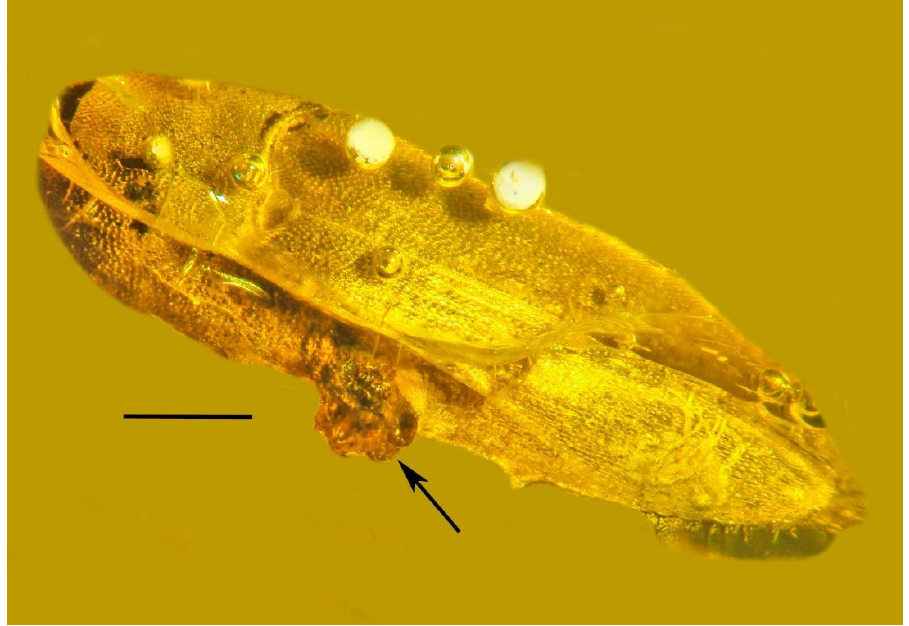
Figure 16. A click beetle (Coleoptera: Elateridae) with attached probable euphorine cocoons (Hymenoptera: Braconidae) (arrow) in Dominican amber. Scale bar = 1.3 mm.